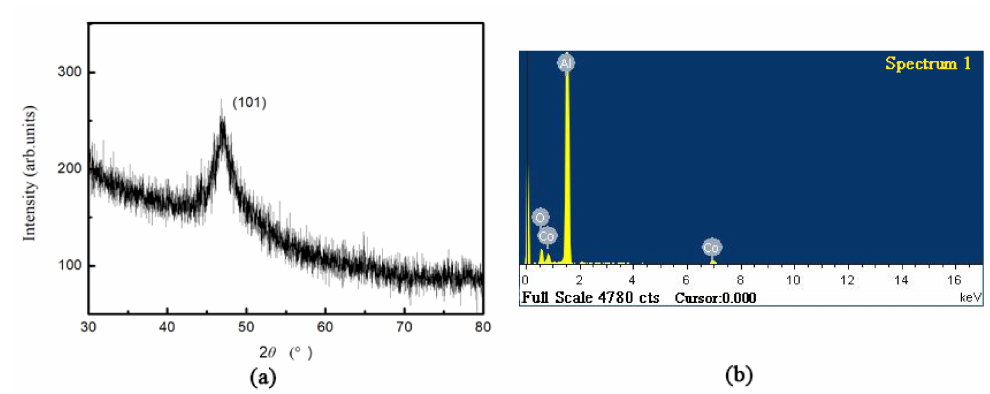
Figure 5. ( a ) X-ray diffraction pattern; ( b ) energy spectrum of the alumina-Co composite film shown in Figure 4c.